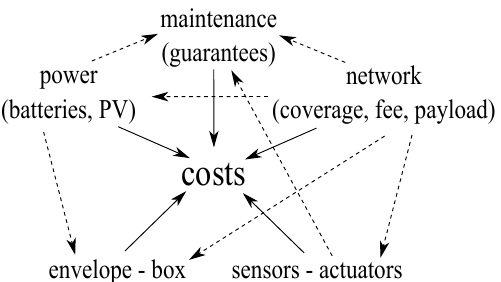
Figure 3. Major aspects to account for in IoT device design—dashed are the impacts of design choices, while continuous lines are their impact on costs.